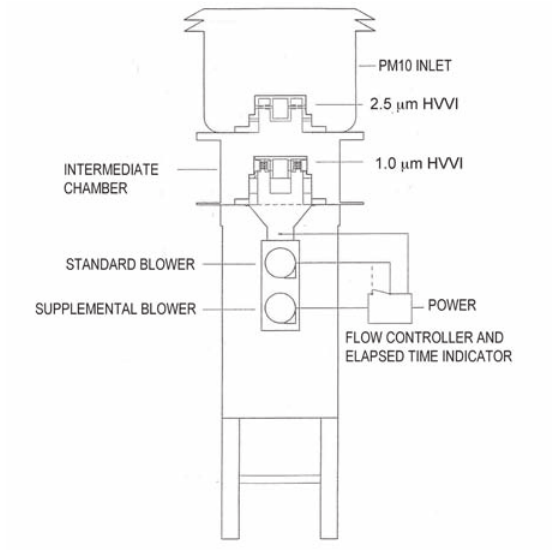
Fig. 3 Schematic of PM